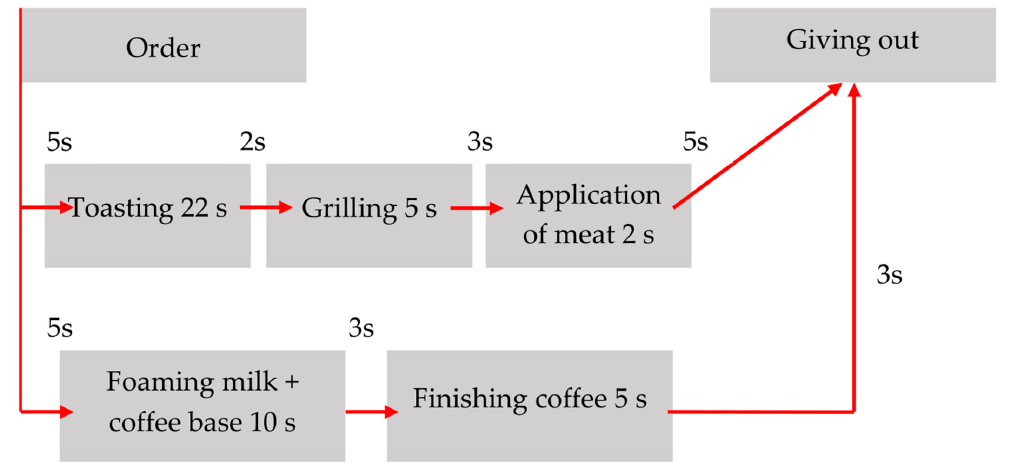
Figure 10. New VSM after the introduction of Lean tools.